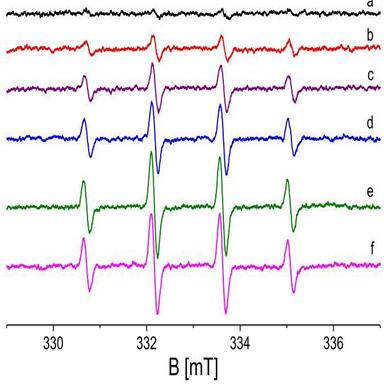
EPR spectra of the DMPO/OH adduct produced by irradiation of an aqueous suspension of CZ5 with visible/NIR light (l > 400 nm) as a function of the irradiation time: 0' (a, black), 5' (b, red), 15' (c, purple), 30' (d, blue), 60' (e, olive), 90' (f, magenta). (For interpretation of the references to color in this figure legend, the reader is referred to the Web version of this article.)